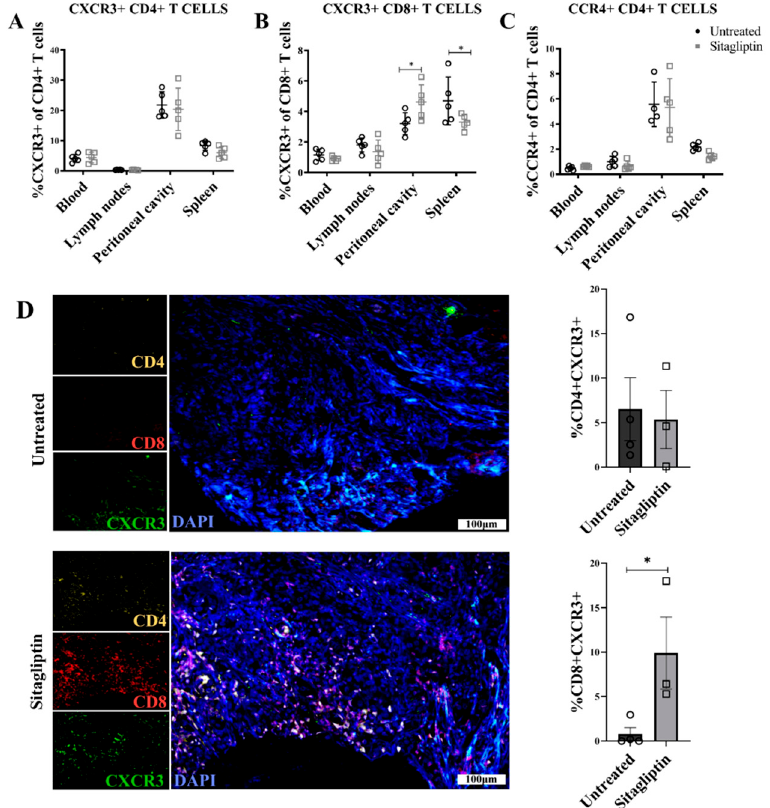
Figure 5. Chemokine receptor expression in ID8 tumour ‐ bearing mice treated with sitagliptin. Leukocytes were isolated from the blood, lymph nodes, peritoneal cavity and spleen of ID8 pROSA ‐ iRFP720 ‐ bearing mice at week four post ‐ inocu ‐ lation and examined using a BD LSRFortessa X ‐ 20 (BD Biosciences). Percentage of ( A ) CXCR3+ CD4+ T cells, ( B ) CD8+ T cells, and ( C ) CCR4+ CD4+ T cells of the corresponding parent population. ( D ) Representative images of ovarian tumour sections stained with CD4 (yellow), CD8 (red) and CXCR3 (green) at four weeks post tumour inoculation. Nuclei were stained with DAPI (blue). Bar graphs show the percentage area of ovarian tumour sections stained with (i) CD4+CXCR3+ and (ii) CD8+CXCR3+. Images were acquired using the VS120 Virtual Slide Microscope (Olympus Corporation, Japan) and processed using the Olyvia software v2.9.1 (Olympus Corporation, Japan). Data were analysed by calculating the percentage area of CD4+CXCR3 or CD8+CXCR3+ colocalisation of total tissue area using a consistent binary threshold in ImageJ v1.0 (National Institute of Health, MD, USA). * = p <